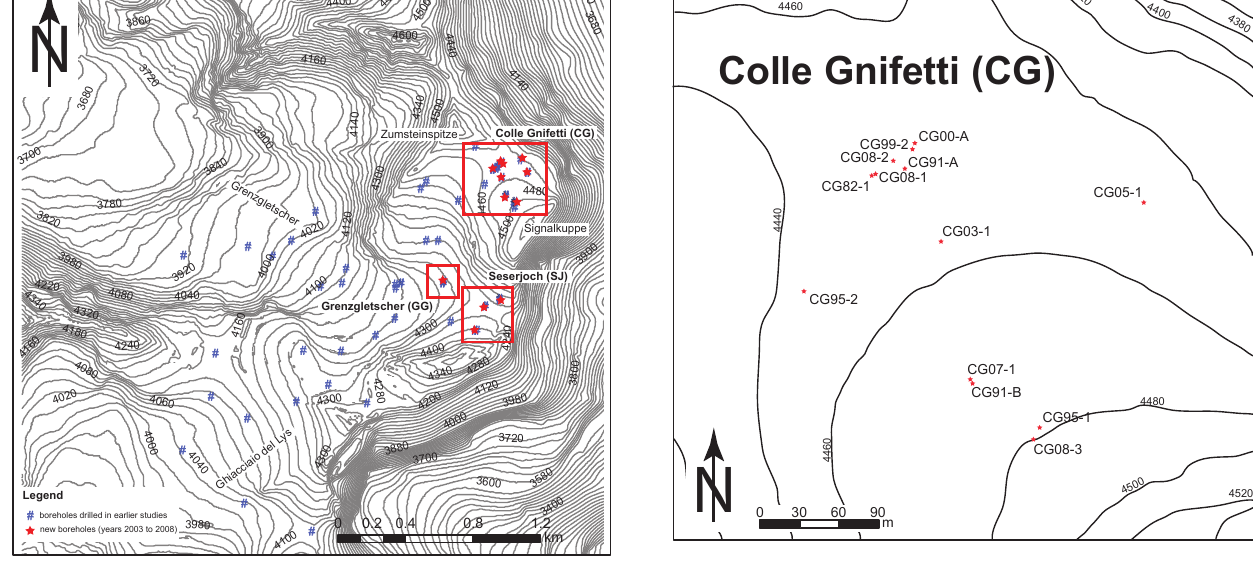
Fig. 1. Location of all borehole sites in the Monte Rosa area. The three insets mark the zoom regions in Figs. 2 and 3.